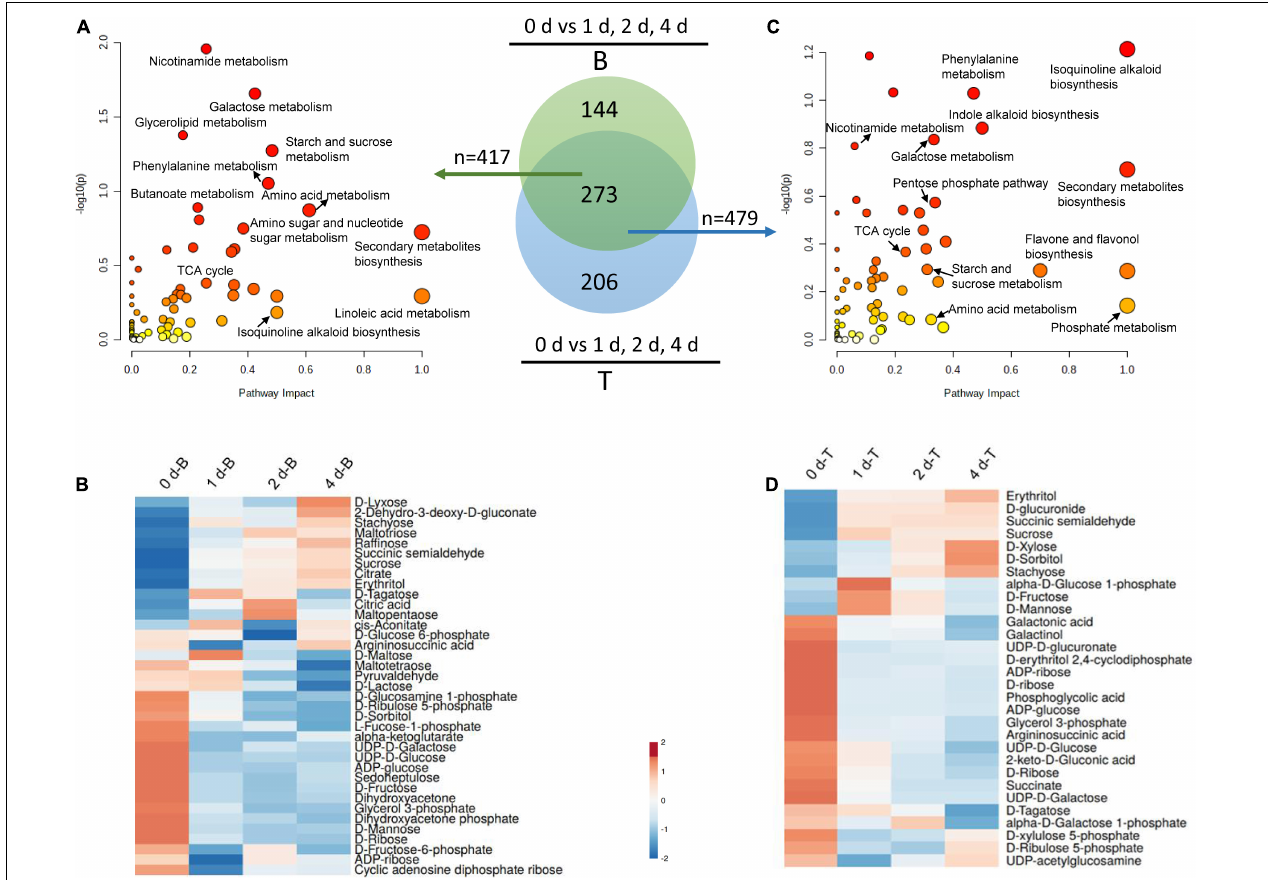
FIGURE 4 | Metabolomics analysis of the basal stems and shoot tips during detached dodder shoots development. (A,C) Pathway impact analysis of the basal stems (day 0 vs. day 1, day 2 vs. day 4) (A) and shoot tips (day 0 vs. day 1, day 2 vs. day 4) (C) , respectively. (B, basal stems; T, shoot tips). The impact indicates the ratio of the number of metabolites mapped to a certain pathway to the total number of metabolites mapped to this pathway. Greater impact factor means greater intensiveness. The P -value was calculated using hypergeometric test through Bonferroni correction, and lower P -value means greater intensiveness. (B,D) Changes of DMs related carbohydrates metabolism in the basal stems (B) and shoot tips (D)